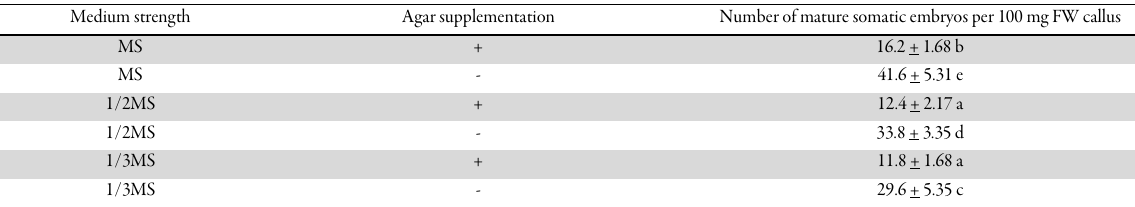
Table 1. Effect of culture medium strength and texture on somatic embryo maturation Medium strength